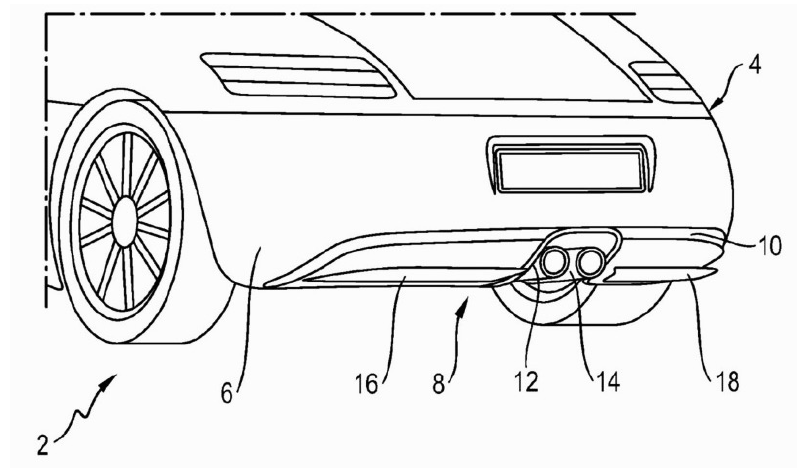
Figure 6. Active diffuser scheme of a Porsche car [33].